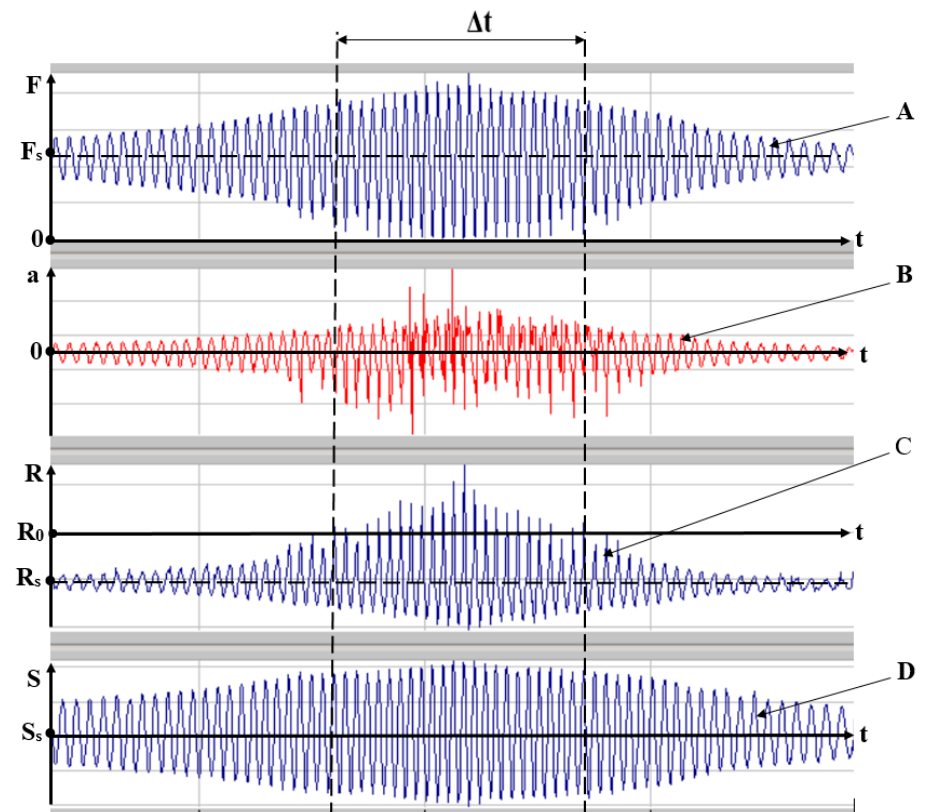
Figure 3. Waveform of the standard suspension of the VW PASSAT CC